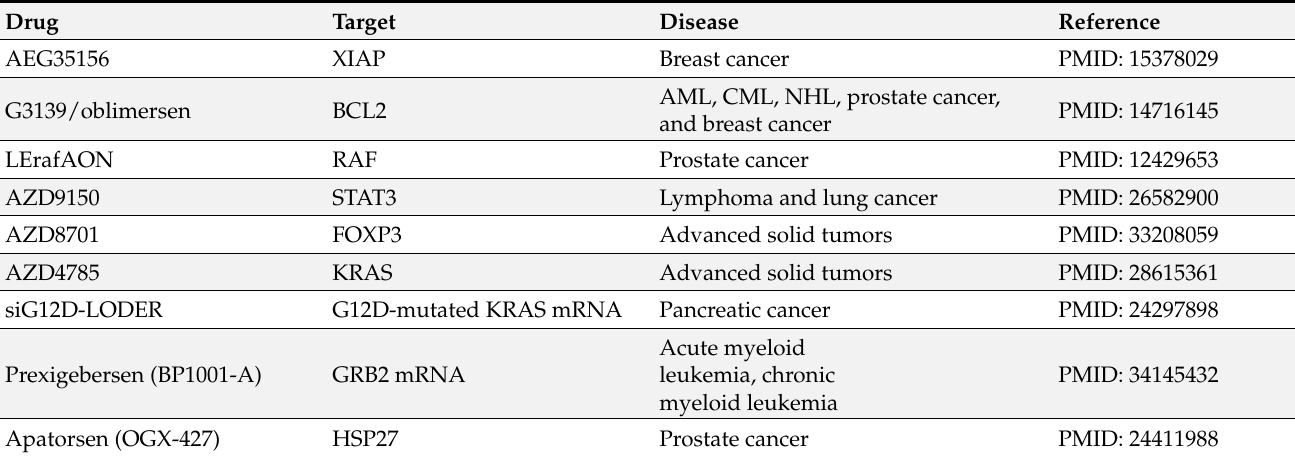
Table 4. List of RNA drugs used in cancer therapies with the indicated target gene, disease treated, and reference